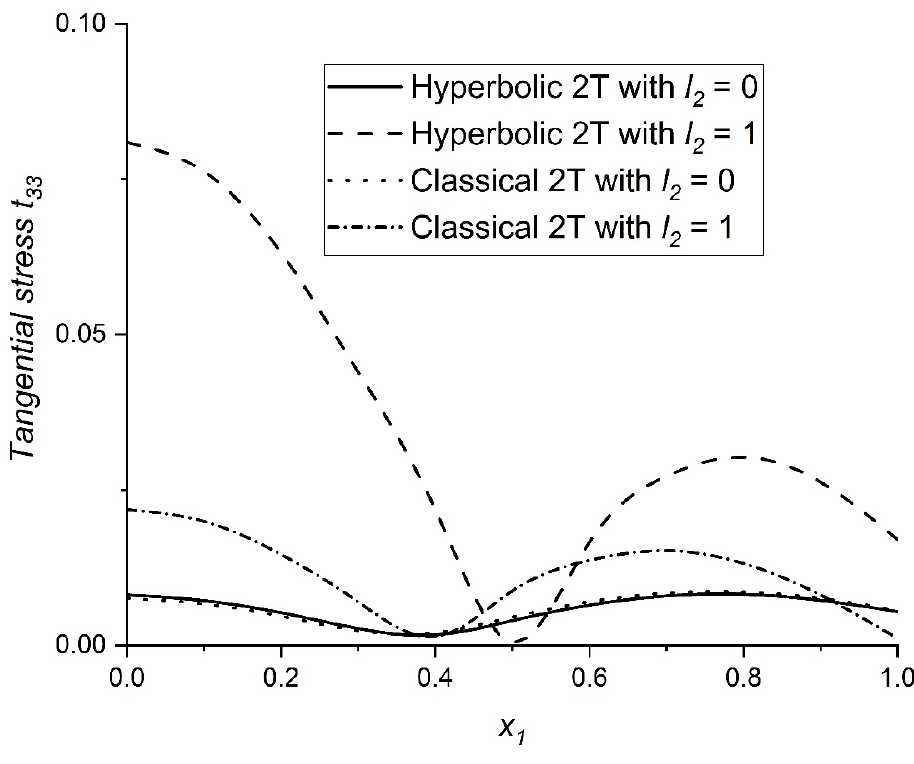
C2T, the 𝑚 (cid:2871)(cid:2870) for length scale parameter 𝑙 (cid:2870) = 1 decreases sharply. H2T shows a higher Figure 8. Variations in dimensionless tangential stress 𝑡 (cid:2871)(cid:2871) . Figure 8. Variations in dimensionless tangential stress t variation in the 𝑚 (cid:2871)(cid:2870) as compared to C2T with length scale parameter. 33 .